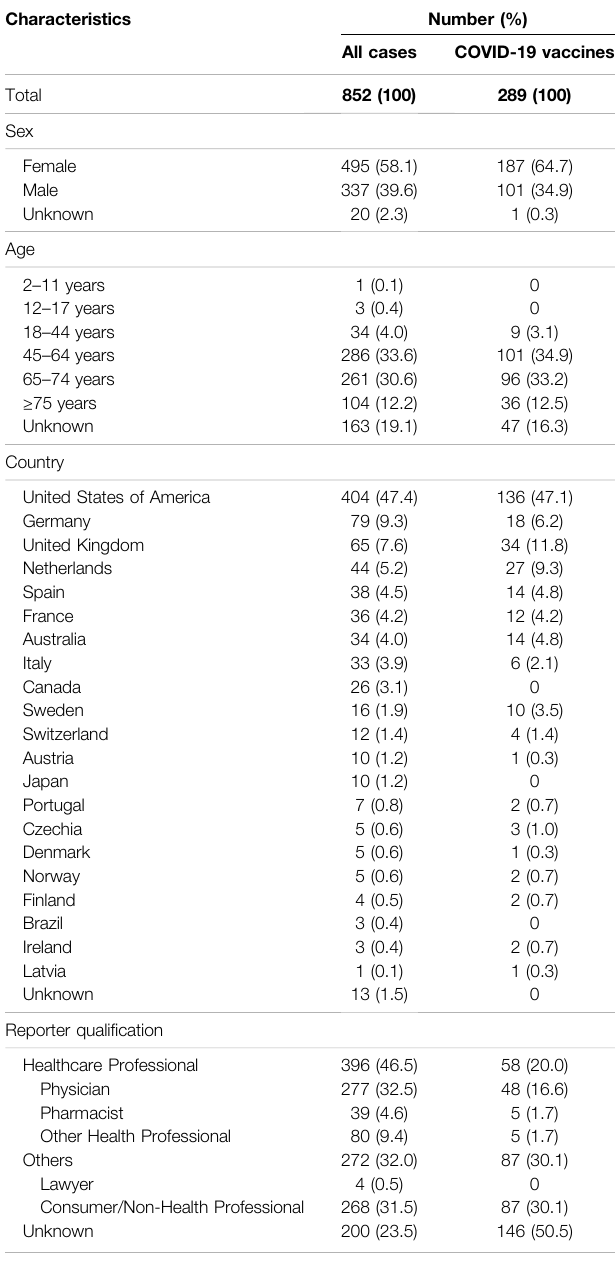
TABLE 1 | Characteristics of the reports of patients with TGA.